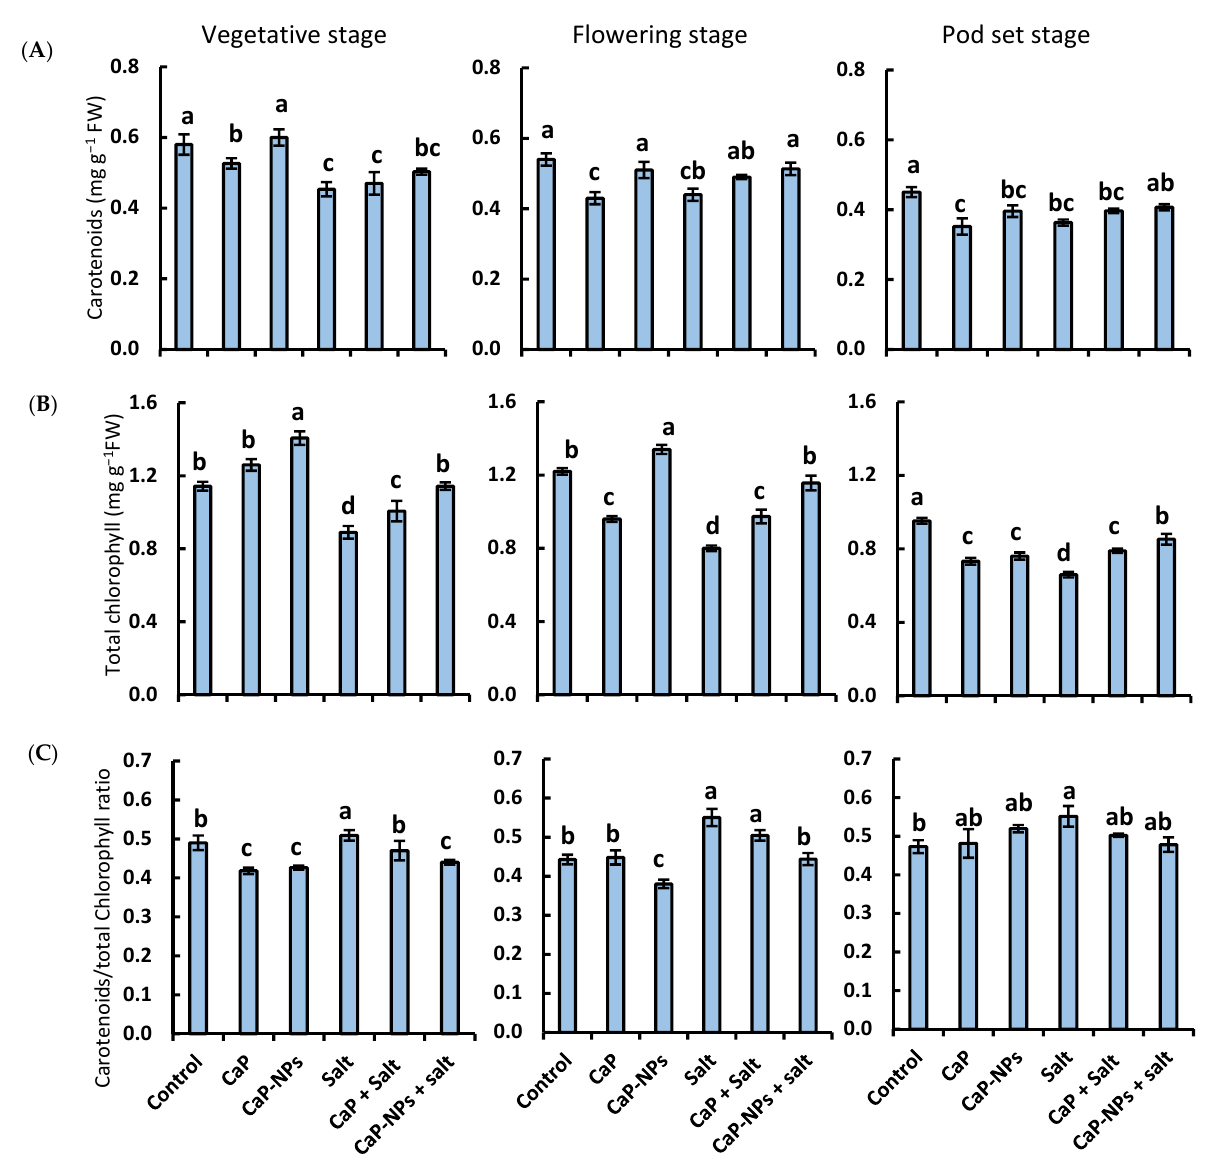
Figure 6. Effect of different treatments on ( A ) carotenoids, ( B ) total chlorophyll content, and ( C ) carotenoids/chlorophyll ratio of broad bean plants in 3 growth stages. The same letters indicate no significant difference ( p < 0.05) as analyzed by the Duncan test. Each value is the average of 3 replicates ± SE.